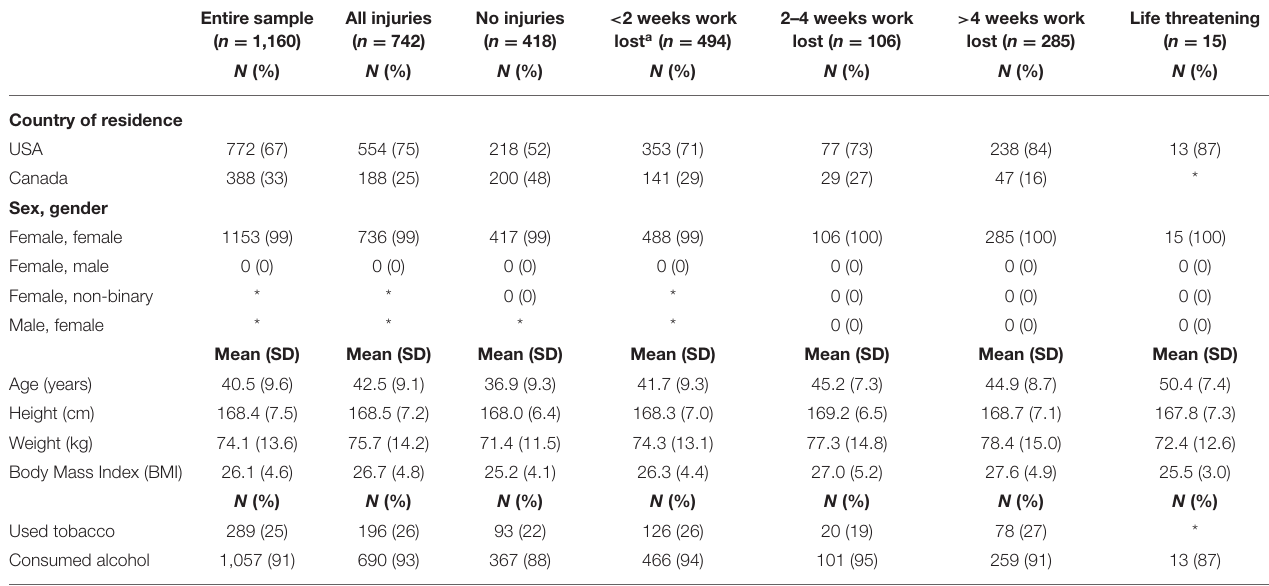
TABLE 1 | Demographic characteristics of active female firefighter survey respondents in the US and Canada, by injury severity as measured by time of work